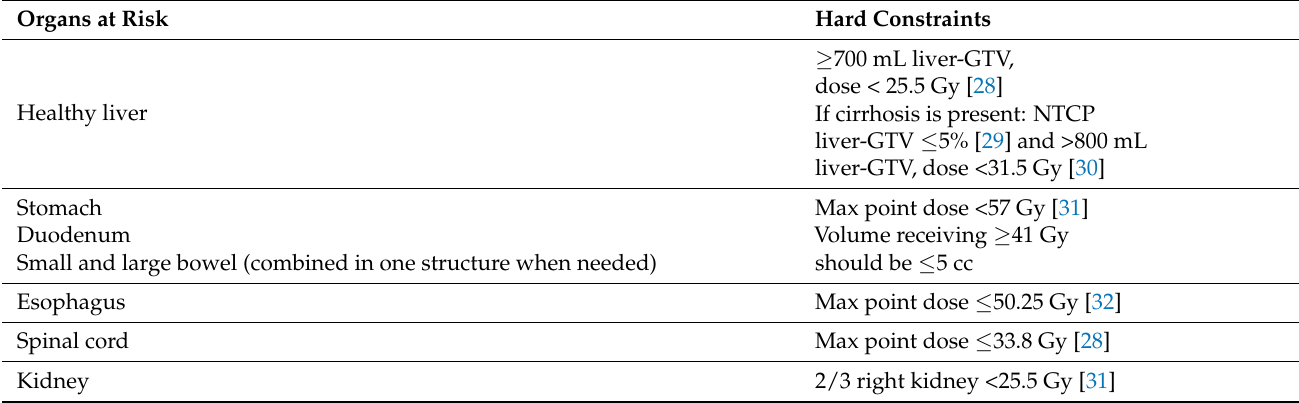
Table 1. Organs at risk